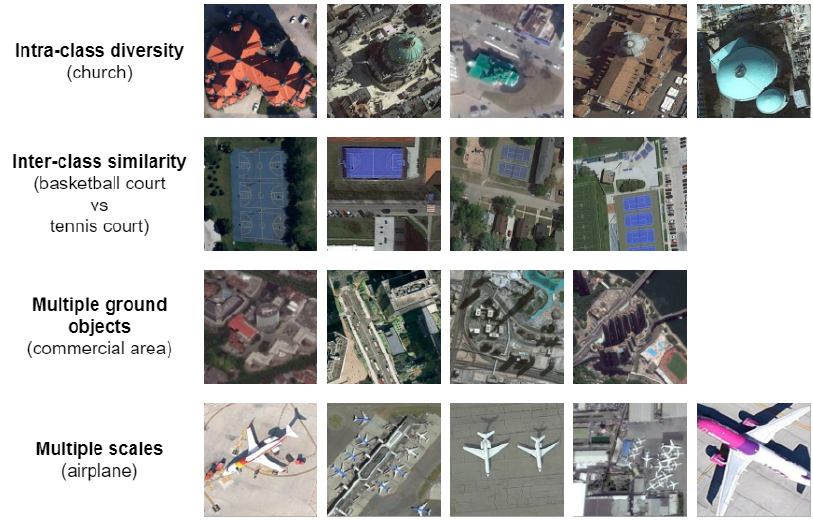
Figure 2. RSI challenges on images from the NWPU-RESISC45 dataset